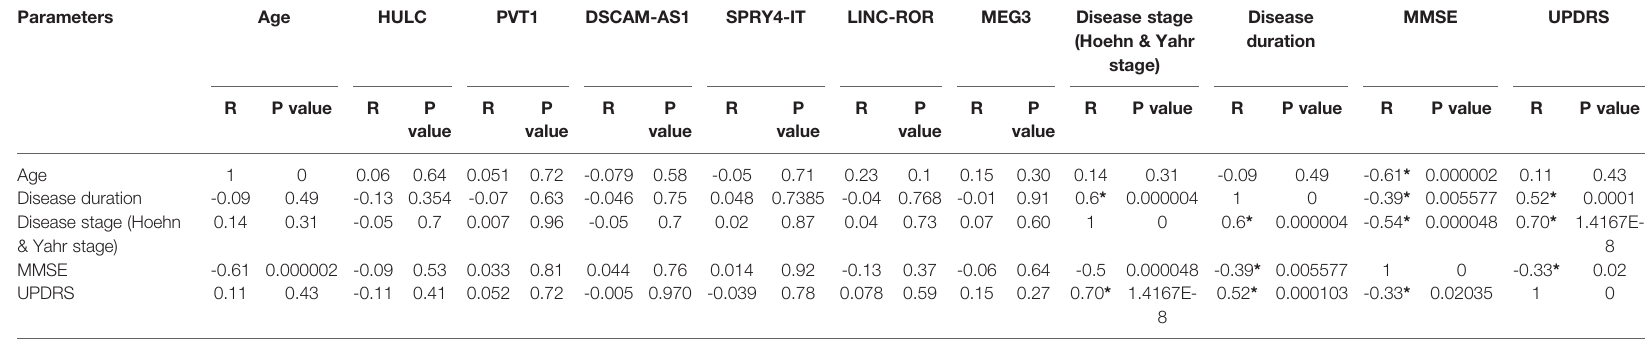
TABLE 5 | The results of partial correlation between expression of lncRNAs and age, Disease duration, Disease stage, MMSE and UPDRS [Controlled for sex, Diseases duration was classi fi ed into 3 ranges (1-5, 6-10 and more than 10 years)]. Parameters